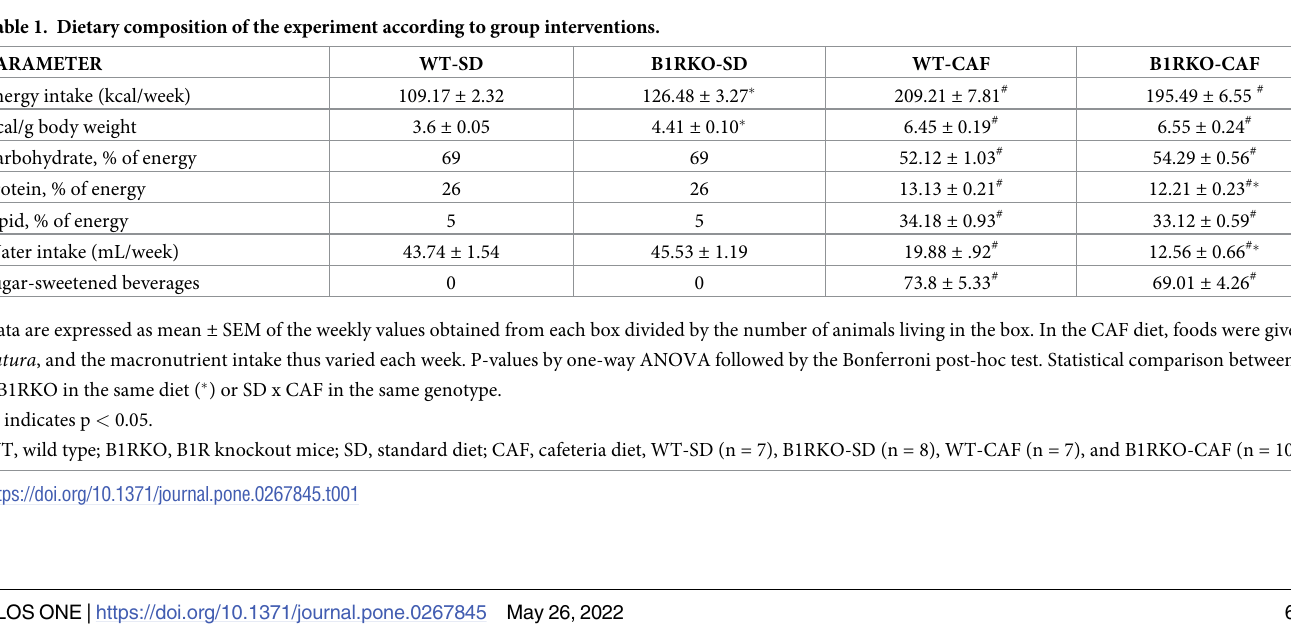
Table 1. Dietary composition of the experiment according to group interventions. PARAMETER